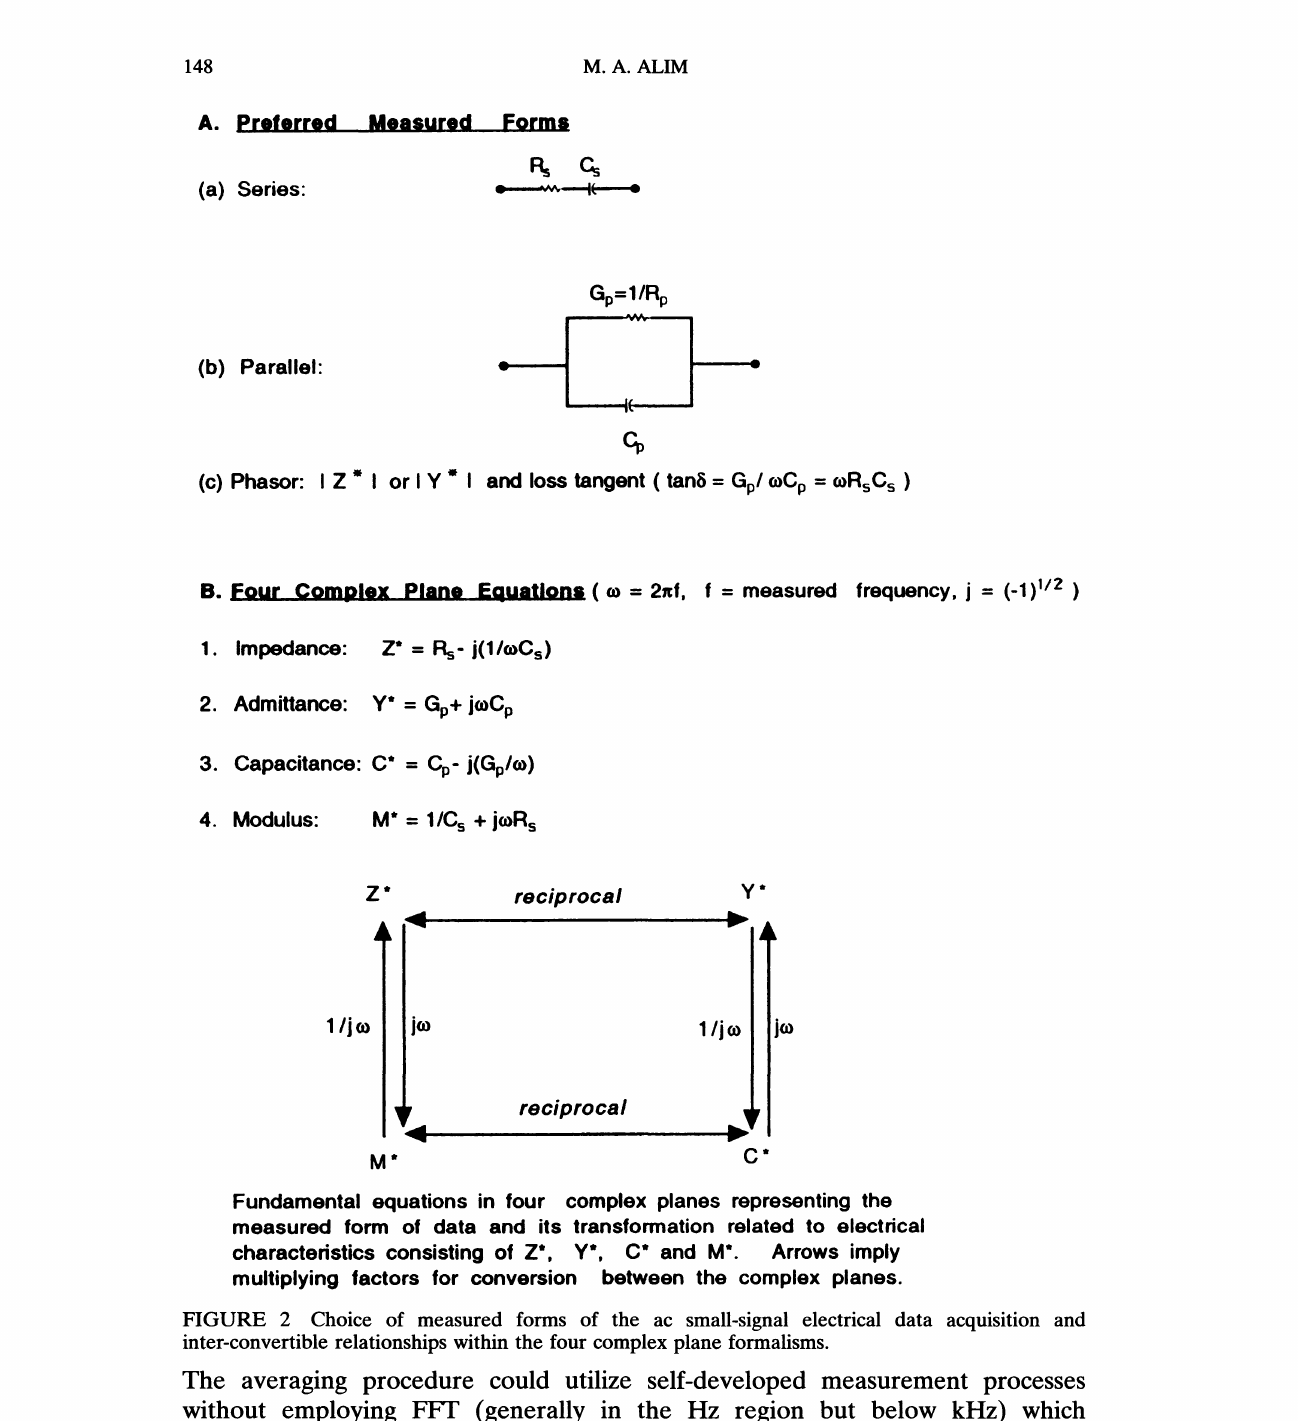
Arrows imply multiplying factors for conversion between the complex planes. FIGURE 2 Choice of measured forms of the ac small-signal electrical data acquisition and inter-convertible relationships within the four complex plane